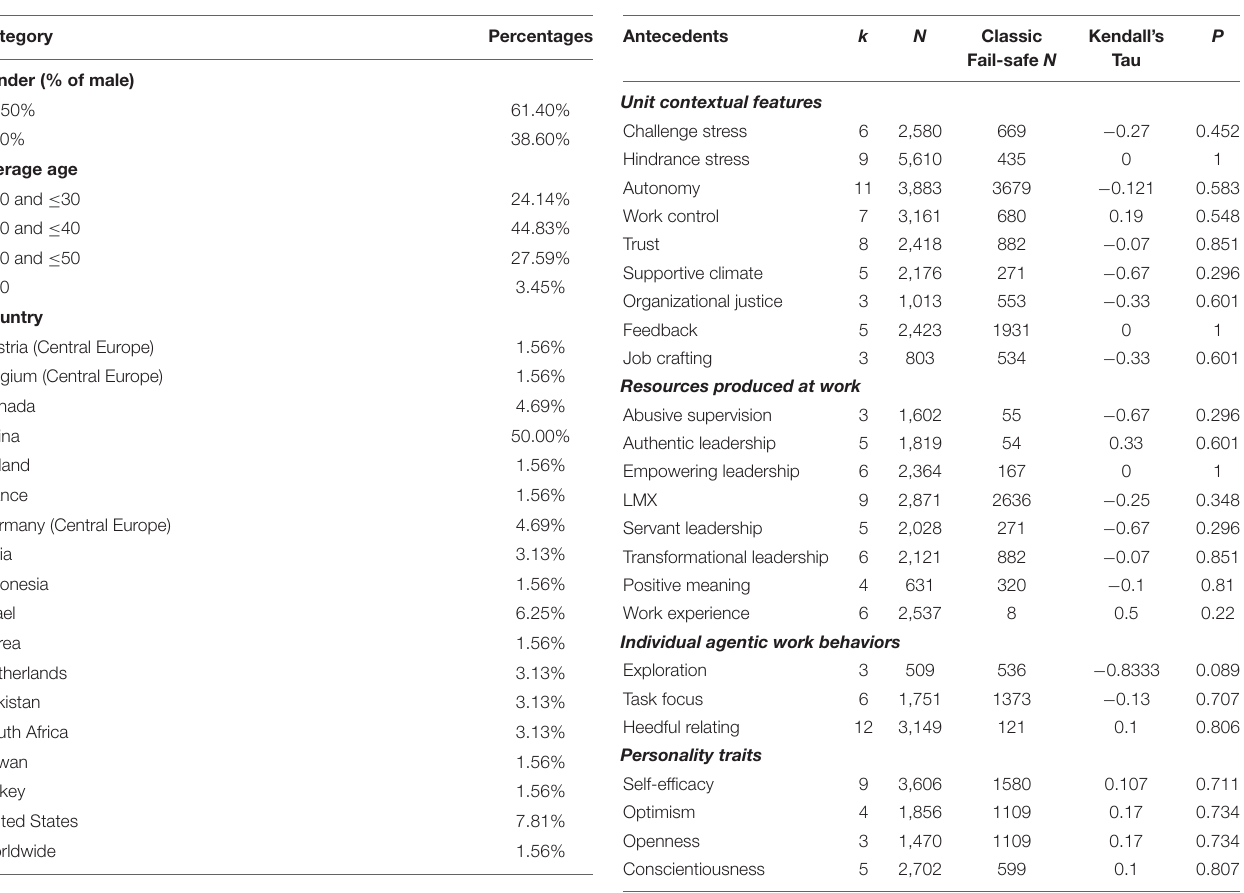
TABLE 3 | Summary of sample information. TABLE 4 | The results of publication bias